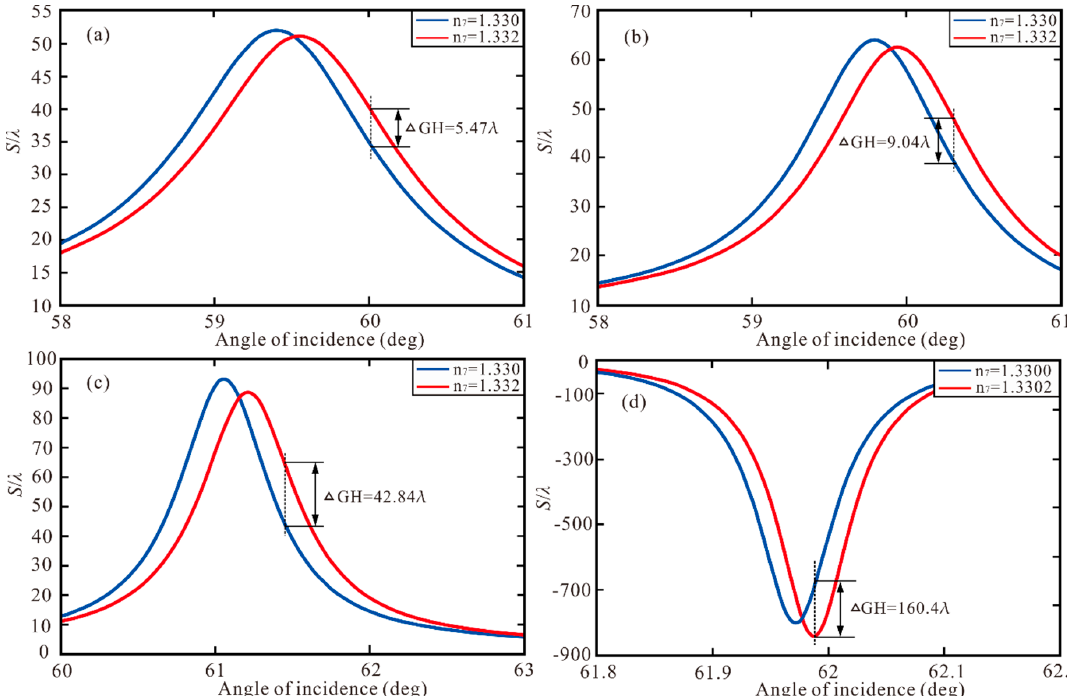
Figure 8. ( a ) GH shift with Au-ITO structure with the Δ n 7 = 0.002, ( b ) GH shift with Au-ITO-graphene (monolayer) structure with the Δ n 7 = 0.002, ( c ) GH shift with Au-ITO-MoSe 2 (monolayer)-graphene (monolayer) structure with the Δ n 7 = 0.002, ( d ) GH shift with Au-ITO-MoSe 2 (monolayer)-graphene (bilayer) structure with the Δ n 7 = 0.0002.